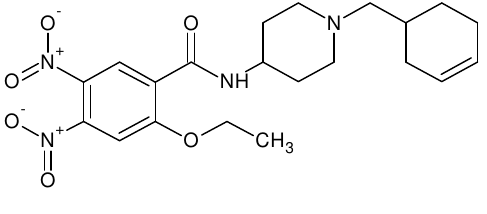
Cinitapride Figure 1 . Chemical structure of cinitapride.